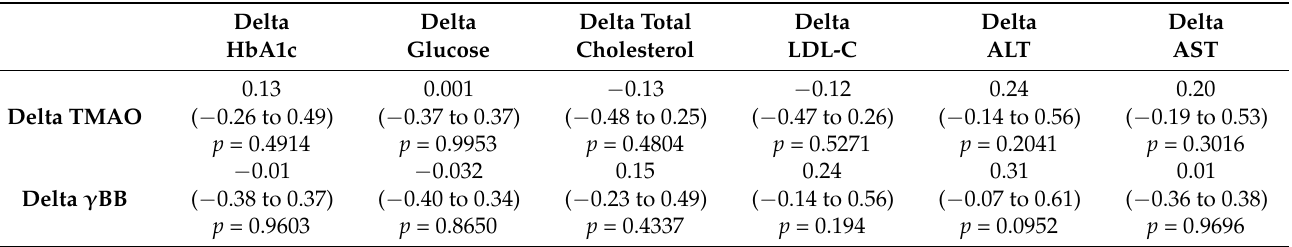
Table 3. Correlation parameters of delta TMAO and delta γBB with biochemical parameters in obese patients.